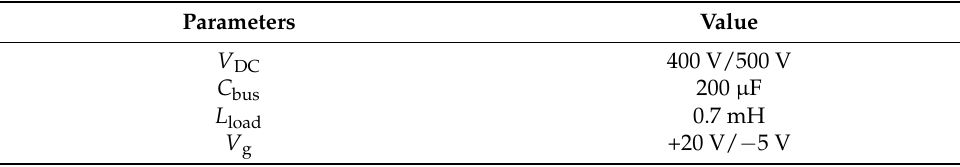
Table 1. Test conditions.